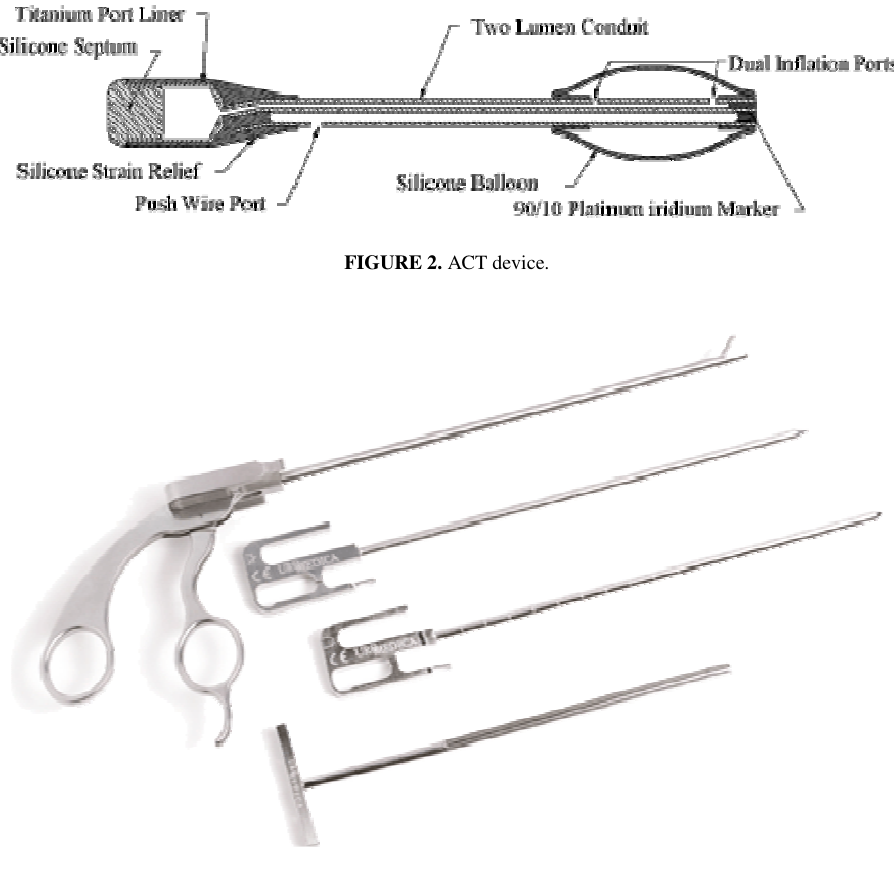
FIGURE 3. Inserting trocar for